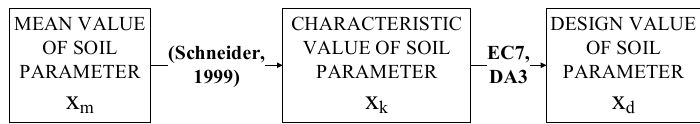
Figure 3. Flowchart for geotechnical parameter values calculation.